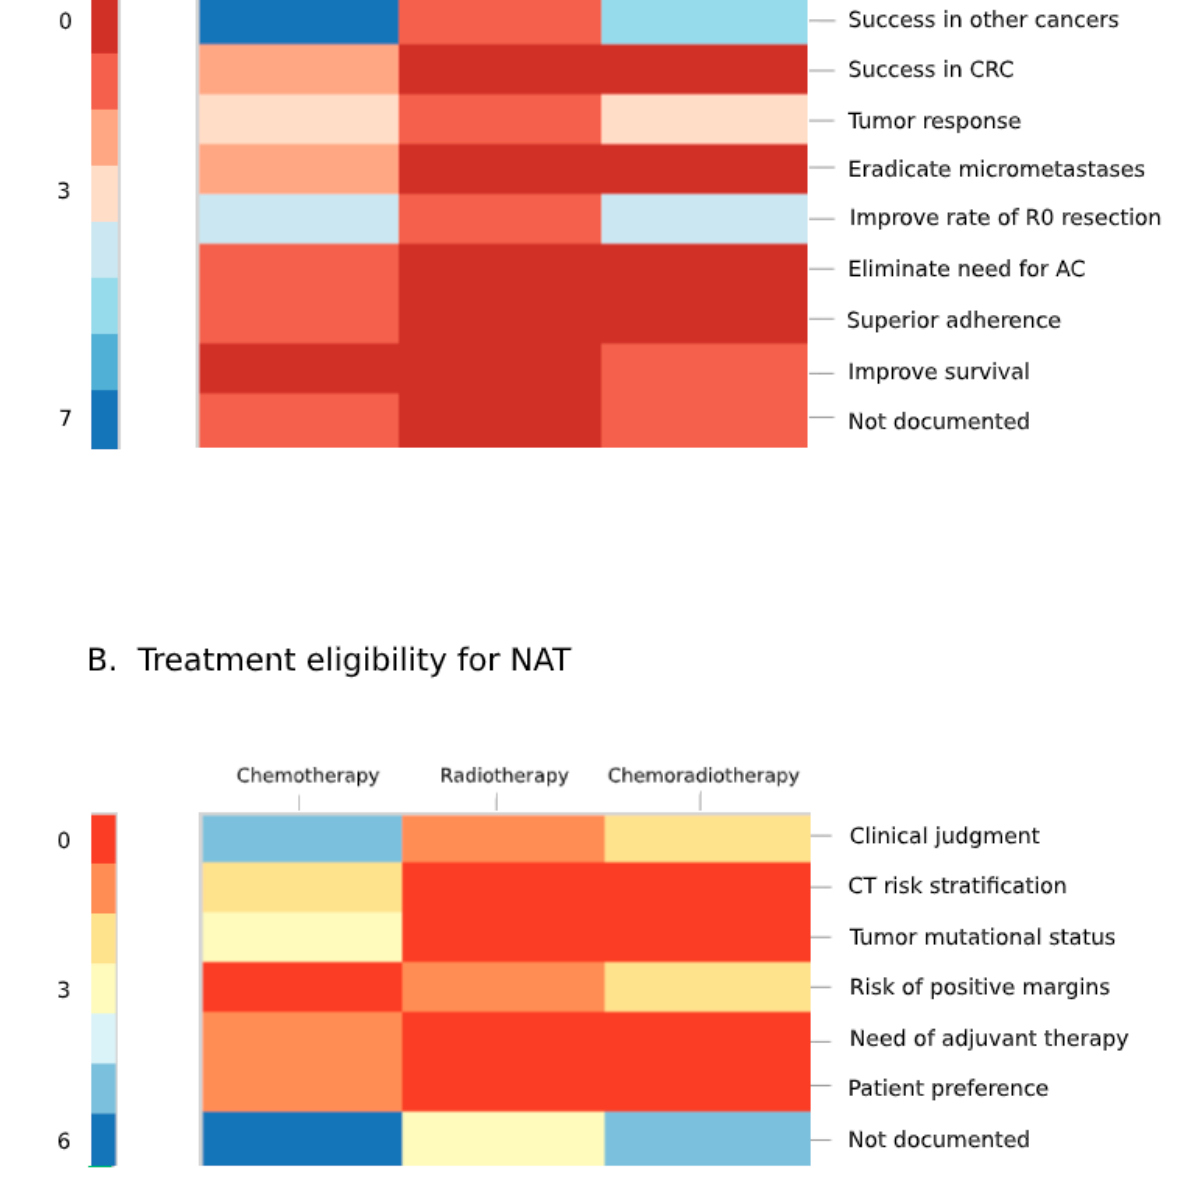
Figure 4. Heatmap graphics showing the rationale ( A ) and eligibility criteria ( B ) for neoadjuvant therapy for T4 colon cancer. Each box in the grid represents the number of studies (color coded per the legend) that use the rationale ( A ) or eligibility criteria ( B ) listed on the y -axis, corresponding to the neoadjuvant therapy listed on the x -axis. (Categories are not mutually exclusive). NAT, neoadjuvant therapy; CRC, colorectal cancer; R0, microscopically negative margins; AC, adjuvant chemotherapy; CT, computed